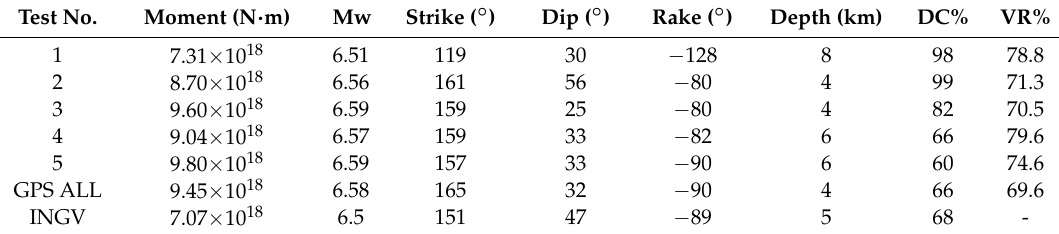
Table 4. Results of the sparse network tests, compared with the solution obtained previously and the INGV